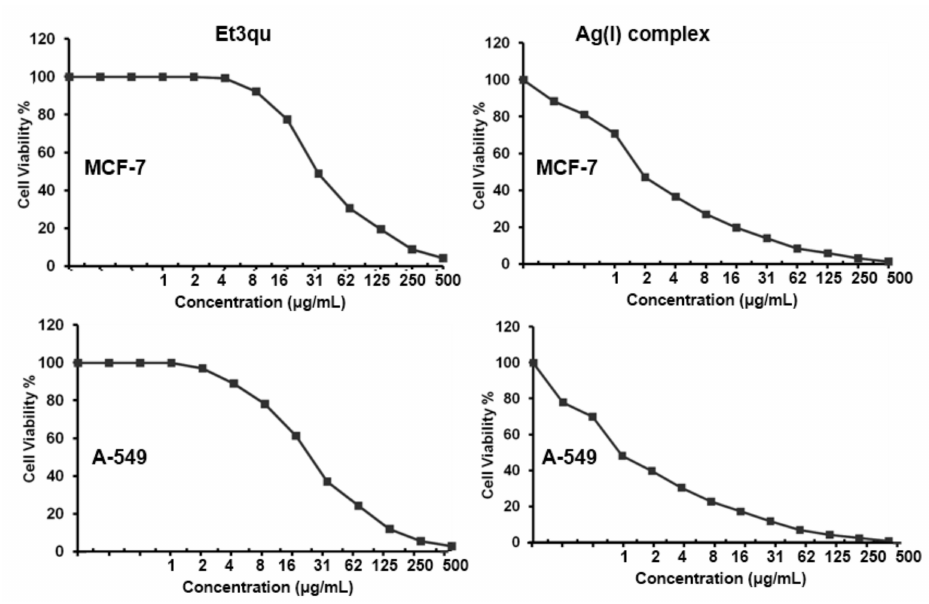
Figure 7. MTT assay of Et3qu and its [Ag(Et3qu) 2 (citrate)] complex. Table 6. Anticancer screening (expressed as IC 50 ( µ g/mL)) of the newly synthesized complex, its corresponding free ligands and the reference drugs against the tested human cancer cell